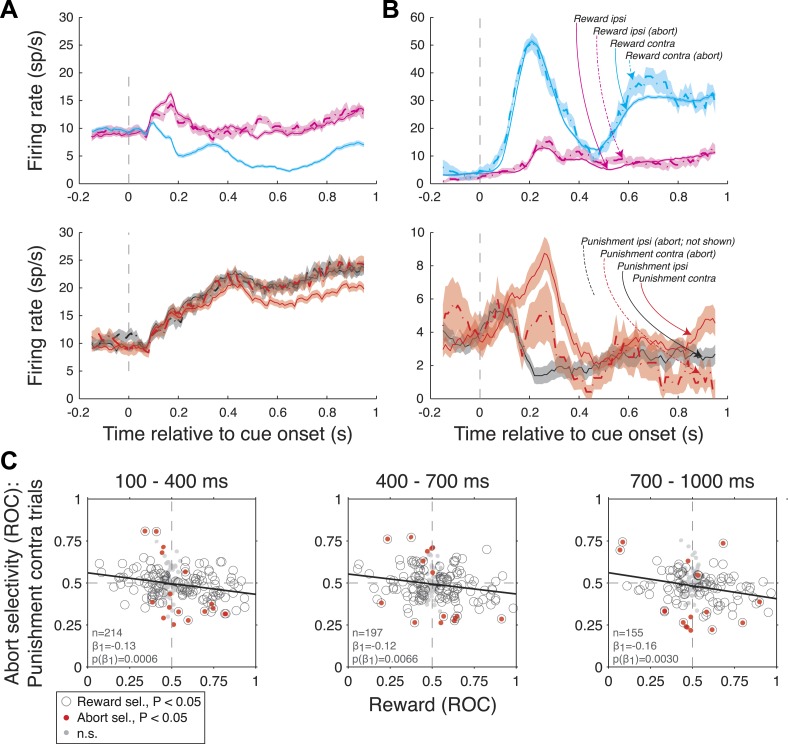
Amygdala firing rate selectivity for aborted trials.(A and B) Example neuron cue-aligned firing rates for aborted (dashed lines) and non-aborted trials (solid lines) on R-present trials (left; R-contra, R-ipsi) and R-absent trials (right; P-contra, P-ipsi). Shading indicates standard error across trials. Note that firing rates for abort trials are not plotted in cases where there were fewer than 6 aborts. (A) Neuron with reward selectivity and spatial-reward selectivity indices <0.5 in all time epochs (p < 0.05). Abort selectivity was significant only on P-contra trials in the 700–1000 ms epoch (index = 0.70, p < 0.05). (B) Neuron with reward selectivity and spatial-reward selectivity indices >0.5 in all time epochs (p < 0.05). Abort selectivity was significant only on P-contra trials in the 700–1000 ms epoch (index = 0.39, p < 0.05). Different y-axis ranges are used for R-present and R-absent trials to illustrate abort selectivity. (C) Relationship between reward selectivity and abort selectivity indices on punishment-contra trials for each time epoch. Plot style indicates the significance of selectivity indices (see legend); solid lines indicate significant regressions (p < 0.05).